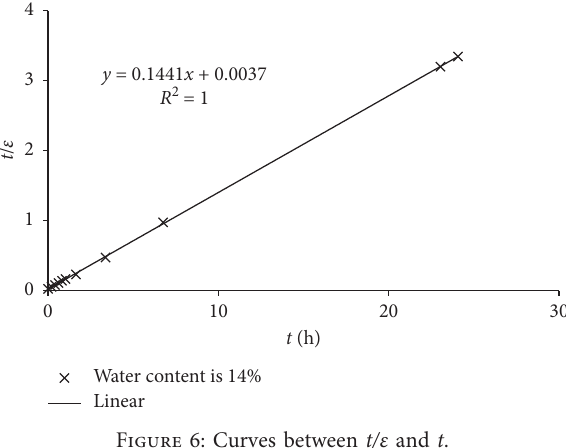
Figure 6: Curves between t/ε and t .